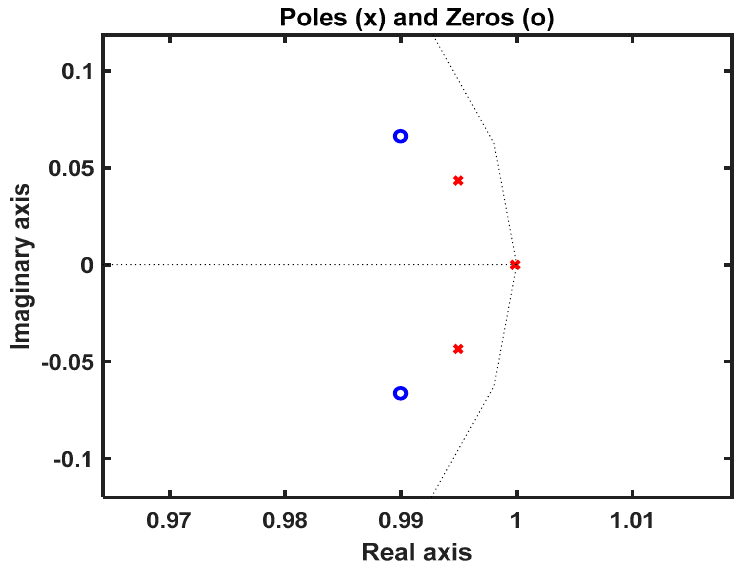
Figure 5. The zero-pole plot for the model.